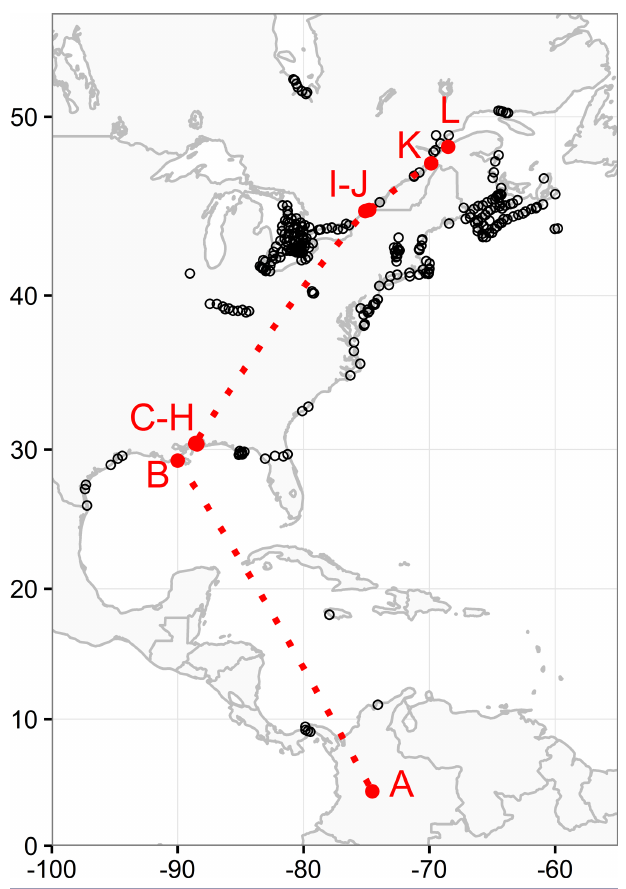
Fig. 4 . Twelve (A-L) Motus stations on which a Swainson’s Thrush ( Catharus ustulatus ), tagged on 16 March 2016 as part of an overwintering study in Colombia, was detected during spring migration (closed red circles; Gonzalez and Hobson, unpublished data ). Black circles show the location of Motus stations that were active between 29 April and 31 May 2016, i. e., between the time this individual left its overwintering site (Fig. 3) and passed by the most northern site (L). Red broken lines depict the great circle path between sites, and may not accurately represent the migratory path of this individual. In addition to giving some indication of migratory connectivity, detections collected at sites A-L can provide information on stopover duration, time of departure, time of passage past each site (Figs. 3, 5), and thus derived metrics including ground speed.